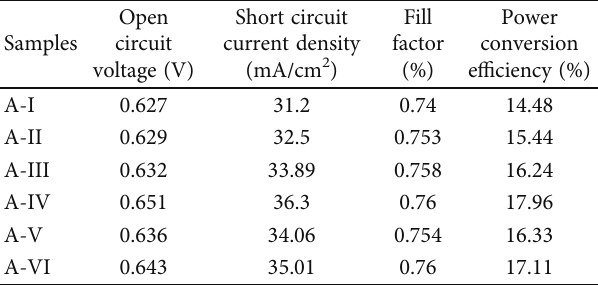
Table 4: I-V measurement values for the samples under direct sunlight.